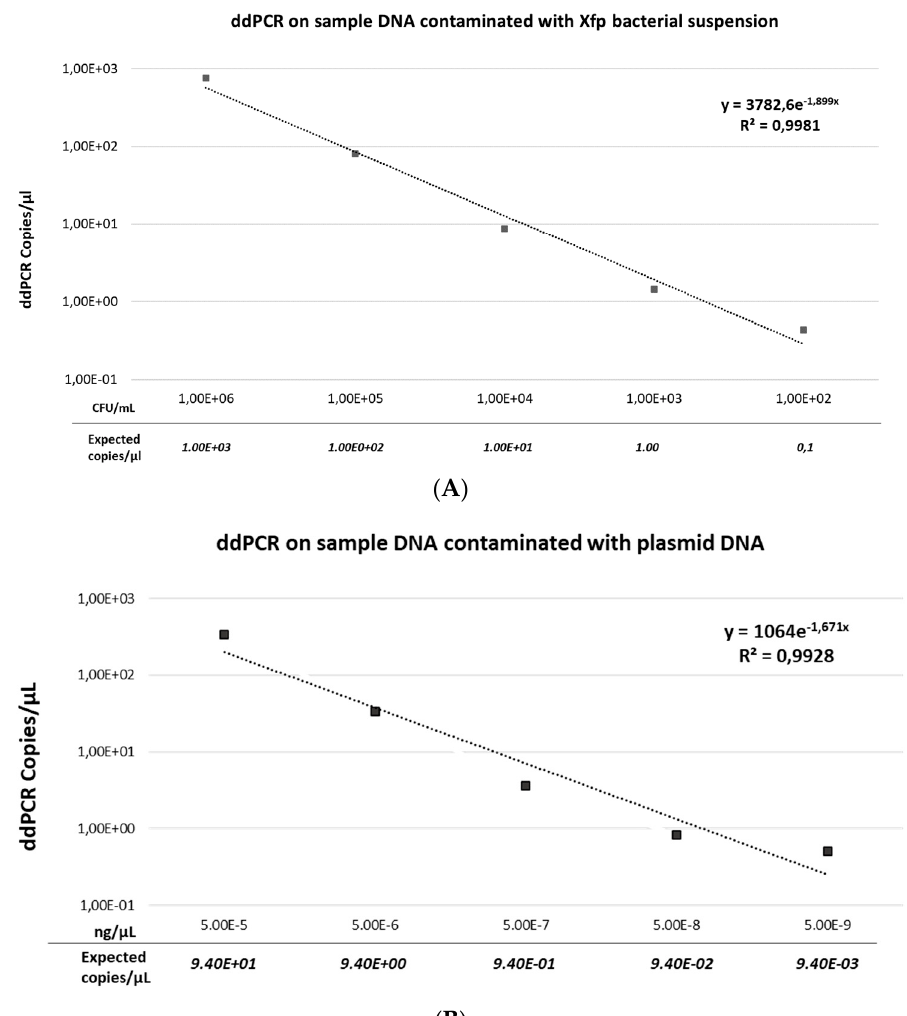
Figure 3. Linear regression of the ddPCR assays generated using the same 10-fold dilution series of bacterial suspension ( A ) and rimM plasmid DNA ( B ) tested with the qPCR assay. Number of copies/µL measured by ddPCR on the y-axis are correlated to ( A ) dilutions of bacterial suspension ranging from 1.00 × 10 6 to 1.00 × 10 1 CFU/mL, and ( B ) dilutions of plasmid ranging from 50 fg/µL to 5 ag/µL. Both figures indicated the corresponding expected copies/µL on the x-axis.